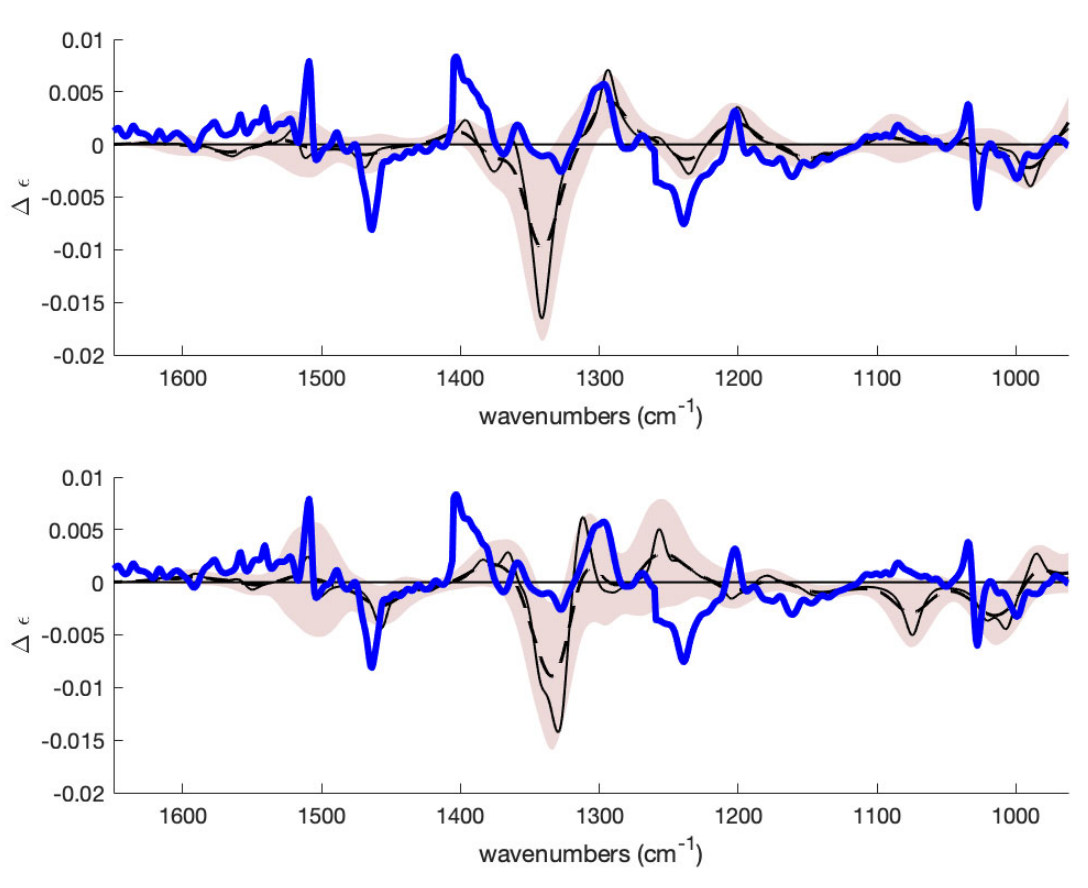
Figure 2. Experimental (solid blue line) VCD spectrum for ( X,S a ) ‐ 8 and VCD spectra of ( R,S a ) ‐ 8 (top) and ( S,S a ) ‐ 8 (bottom) calculated at the plain PCM ‐ B3LYP/6–31G* (solid black lines) or by its model ‐ averaged (MA) version (dashed black lines). The MA ‐ PCM ‐ B3LYP/6–31G* calculation comes with an error estimate which is shown as a shaded